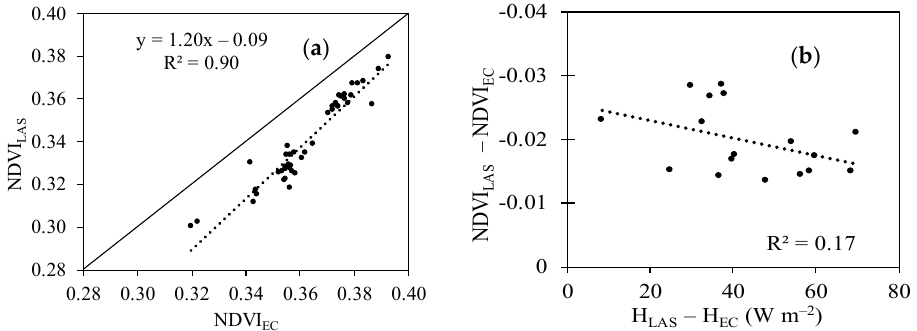
Figure 7. Scatter plots of ( a ) NDVI LAS and NDVI EC , and ( b ) NDVI LAS − NDVI EC compared to H LAS − H EC .